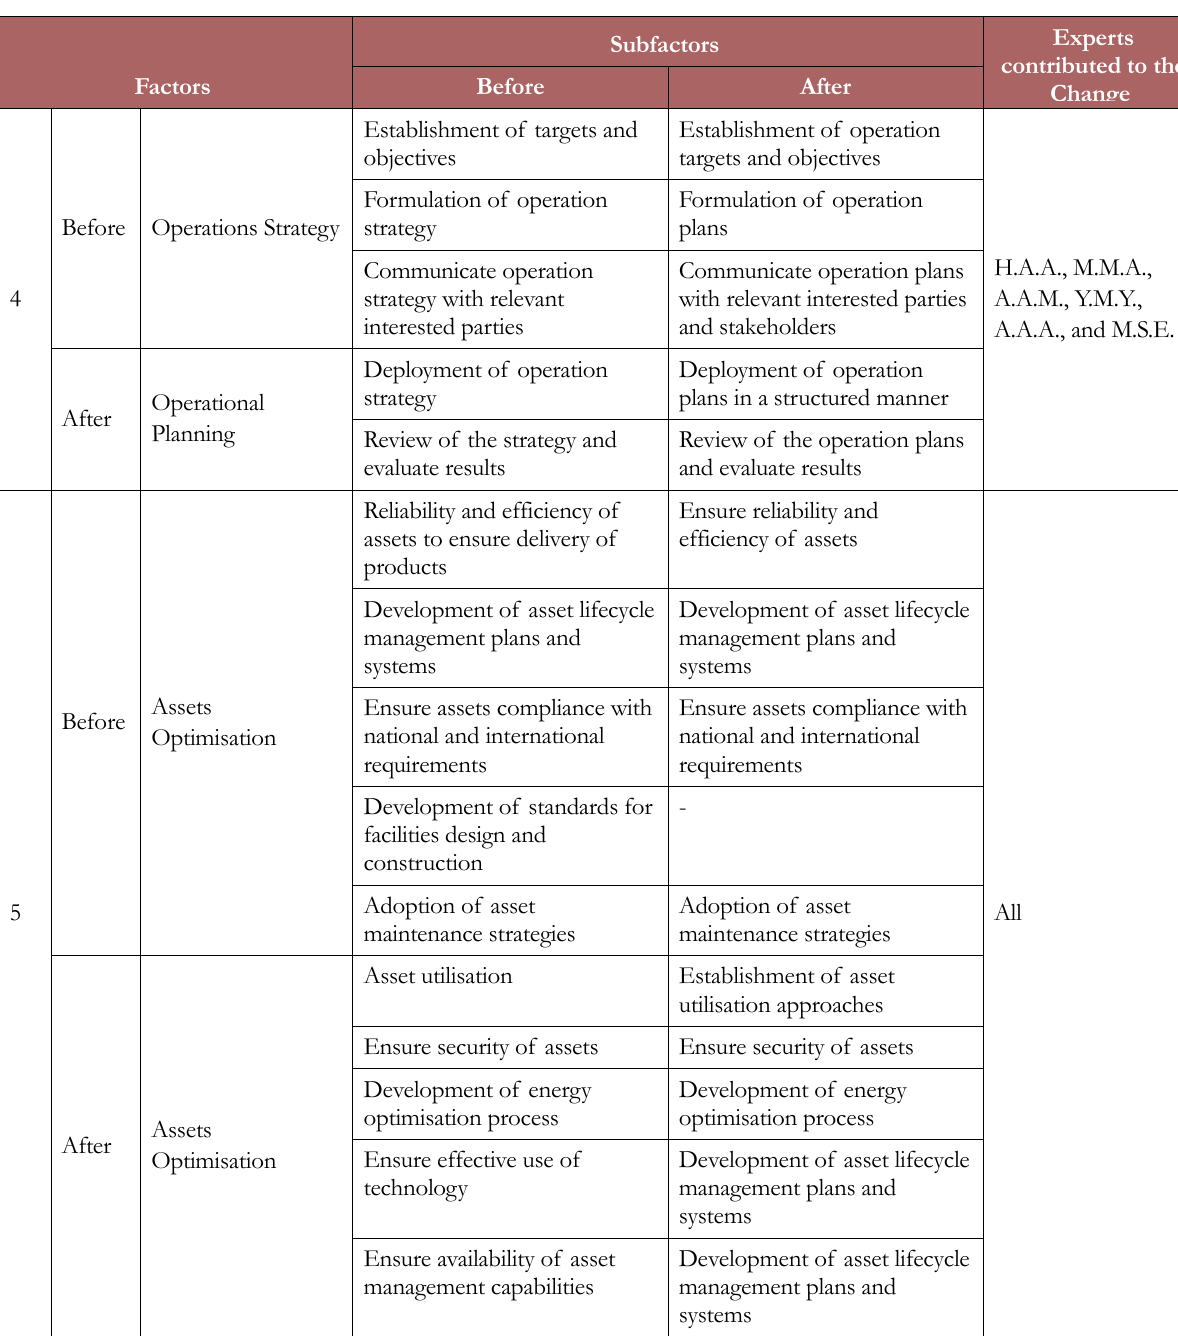
Table 3. Key Changes for Initial AHP